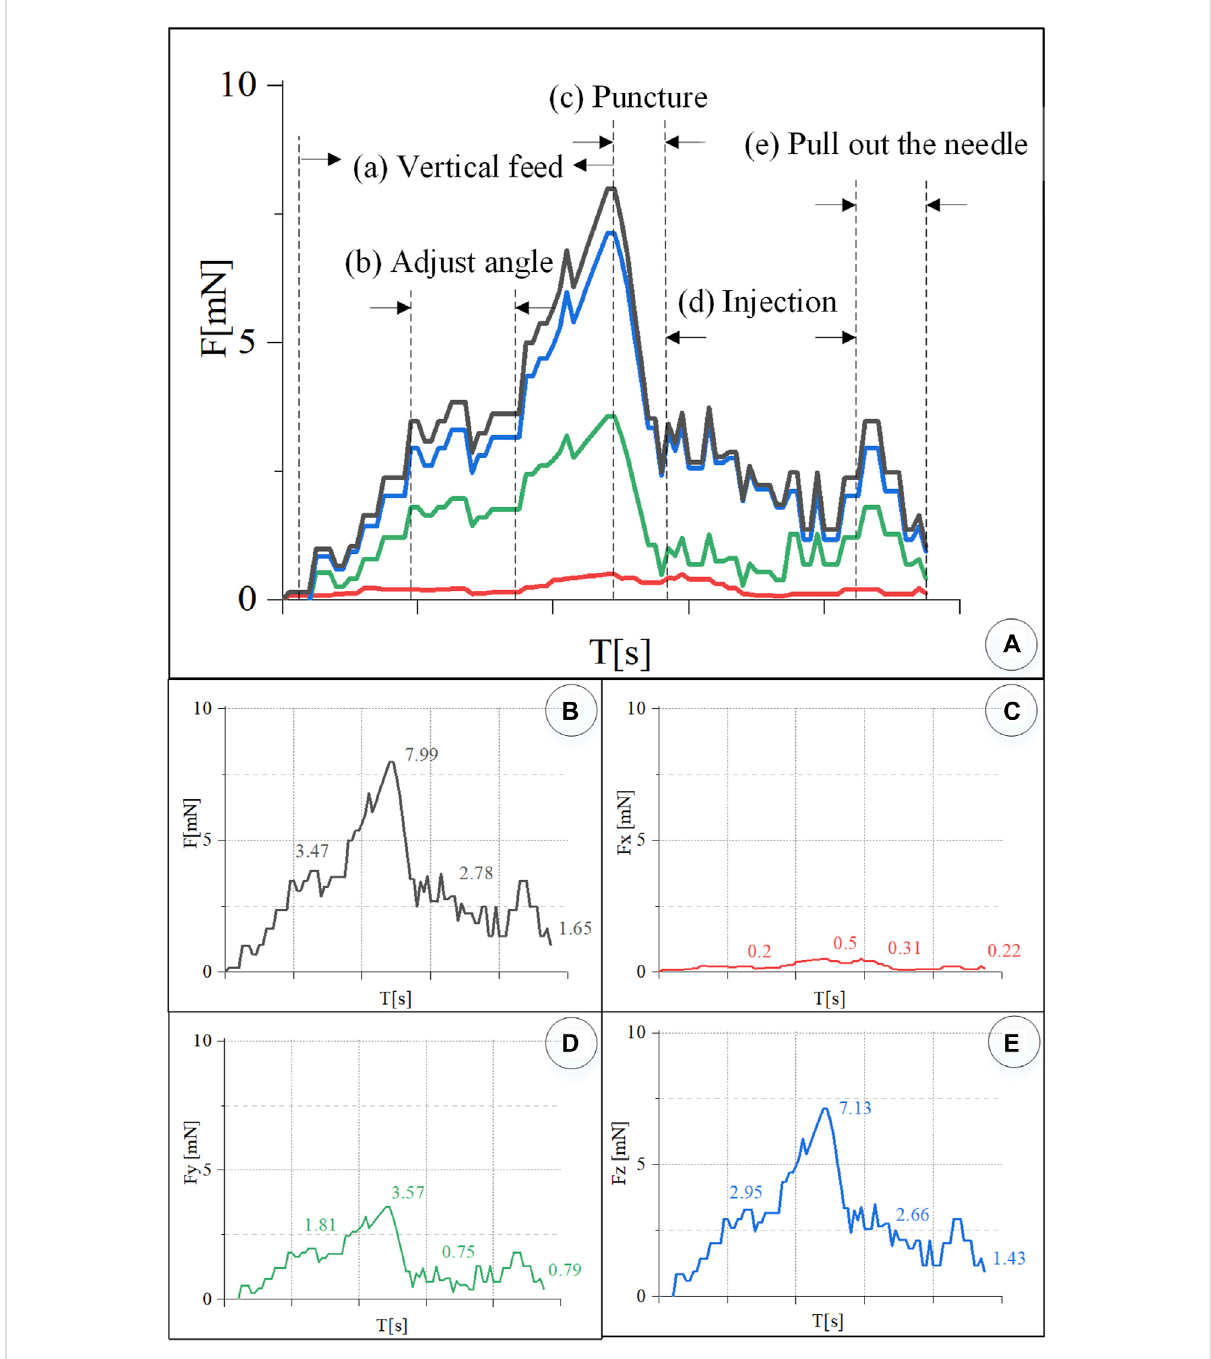
FIGURE 9 Real-timethree-dimensionalmicro-forcecurveofretinalveinpunctureinjectionoftheisolatedporcineeyeball. (A) Punctureprocessisdivided into linear feed, angle adjustment, puncture, injection, and sleeve needle withdrawal stages. (B – E) Real-time curve of force F , F x , F y , F z ,